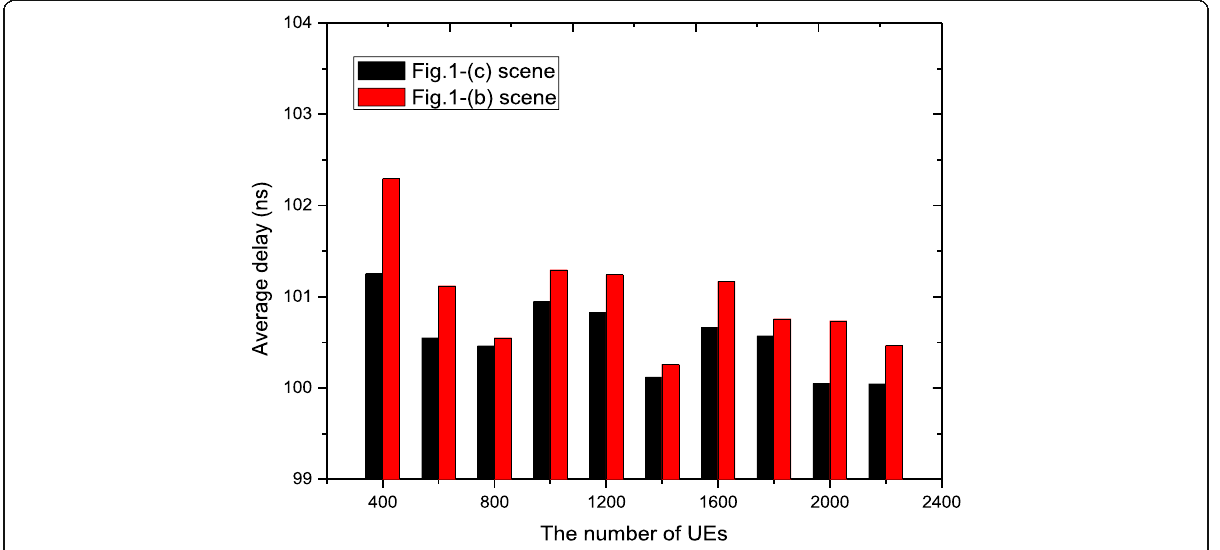
Fig. 20 Average delay for the DTO-MROD scheme under the different scenes in Fig.